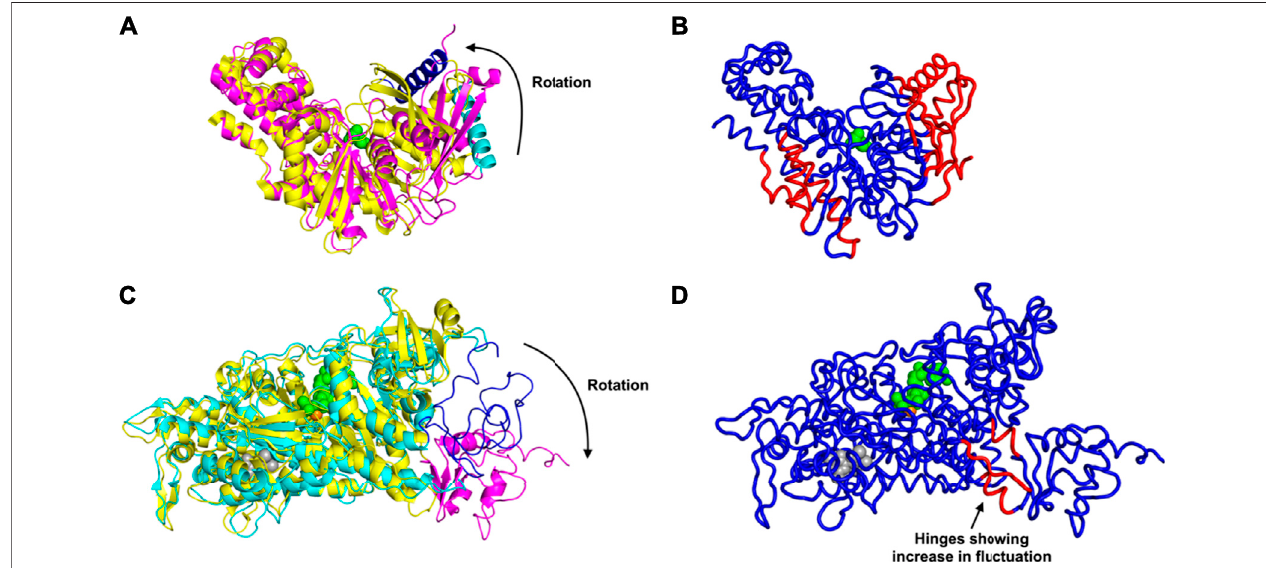
FIGURE 1 | Conformational Transition and Changes in Fluctuations Induced by Ligand Binding, for glucokinase shown in (A) as superimposed unbound and bound structuresand (B) bound.Andsimilarlyforthemyosinmotorproteinin (C) unboundandboundstructuressuperimposedand (D) bound. (A) Rotationanddomainreorganization uponbindingandreleaseofglucose(shownasgreenspheres).Glucoseboundclosedform(PDBID:1V4S)isshowninmagentaandtheopenform(PDBID:1V4T)afterglucose is released in yellow. Glucokinase small domain helix residues 117 – 137 are shown in blue in closed form and in cyan in open form to highlight the domain rotation. (B) Increased fl uctuations (red) and decreased fl uctuations (blue) upon binding of glucose to glucokinase. (C) Rotation of the C-terminus (residues 692 – 776) of the myosin motor proteinuponligandbinding.C-terminusresidues692 – 776areshowninmagentaintheligandboundform(2JHR)andinblueintheapostructure(PDB:2Y0R).TheligandADP metavanadateisshowningreenspheres,magnesiumionasanorangesphere,andpentabromopseudilinasgreyspheres. (D) Siteshavingincreased(red)anddecreased(blue) fl uctuationsinthemyosinmotorproteinuponligandbinding.Inthecaseofthecentralbindingofglucosetoglucokinase,theseincreased fl uctuationsareonthetwooutsideparts of the structure but in the myosin motor protein, they are instead at the central hinge, indicating a kind of dynamic fl exibility between the two domains of this protein.